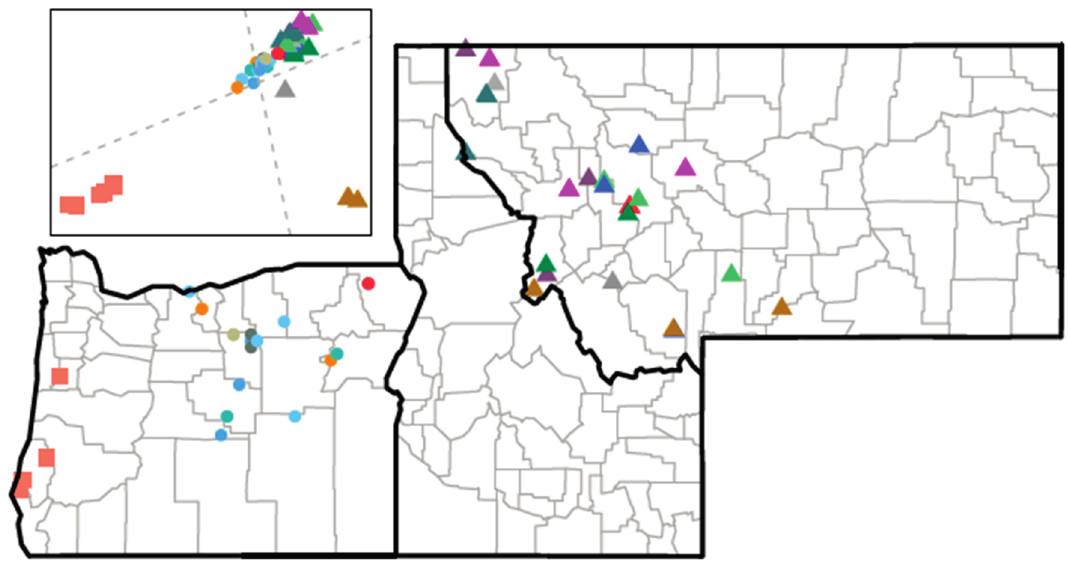
Figure 11. Map displaying geographical location and relatedness of animals. Points on the map give locations of the samples taken from the 45 animals. Squares denote blacktail deer; triangles and circles are mule deer sampled in Montana and Oregon, respectively. Points of the same color represent related groups of two to six animals shown in the bottom dendrogram of Figure 9. Inset displays the first two (scaled) principal component scores, after rotation indicated by the dotted gray PC score axes, derived from the 1268 × 1268 correlation matrix of the vectors of mixture-model estimated probabilities for the 1268 viruses present in at least two